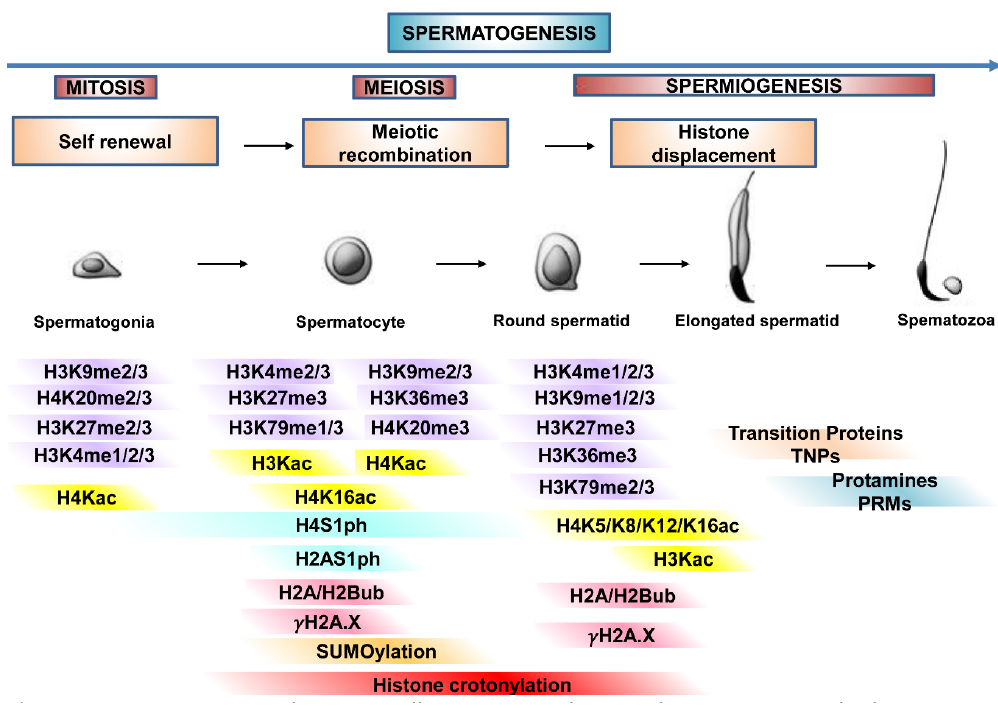
Figure 2. Histone PTMs regulate germ cell progression. The main histone PTMs involved in chromatin dynamic organization during proliferation, meiosis, and differentiation of germ cells, from spermatogonia to spermatozoa (spermatogenesis). In detail, histone PTMs during germ cell progression, self-renewal, meiotic recombination and histone-protamine transition.